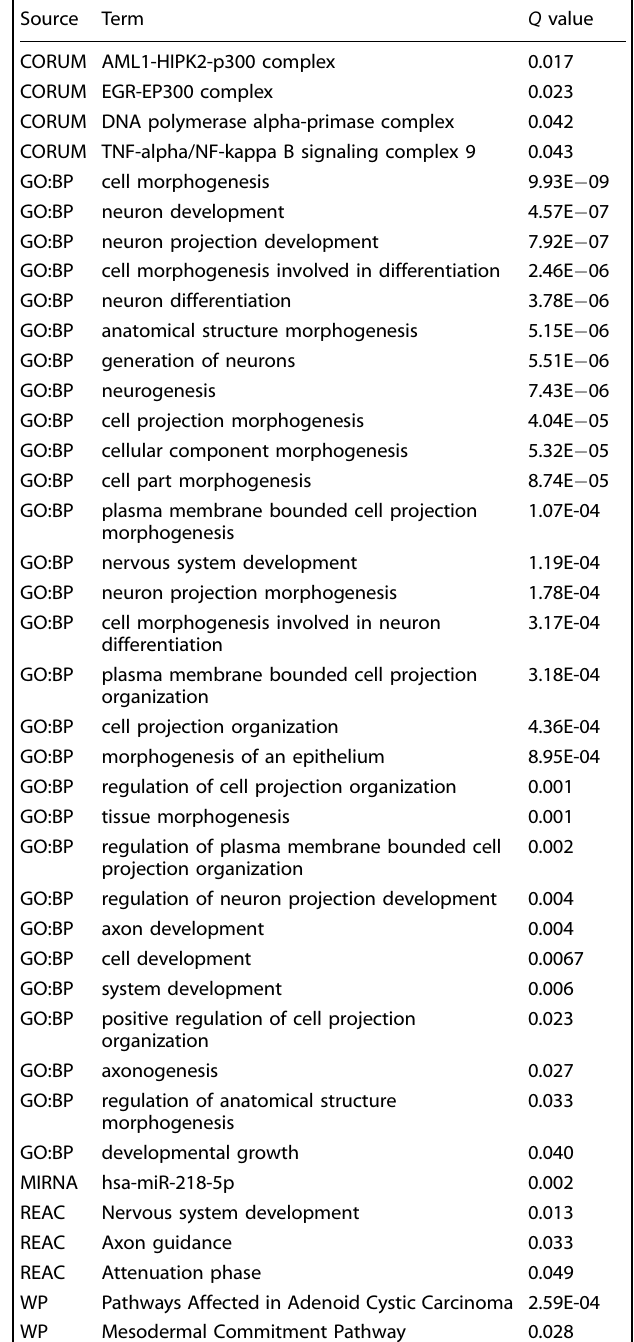
Table 3. Pathway enrichment analysis of red gene module for drug treatment in DAOYs.